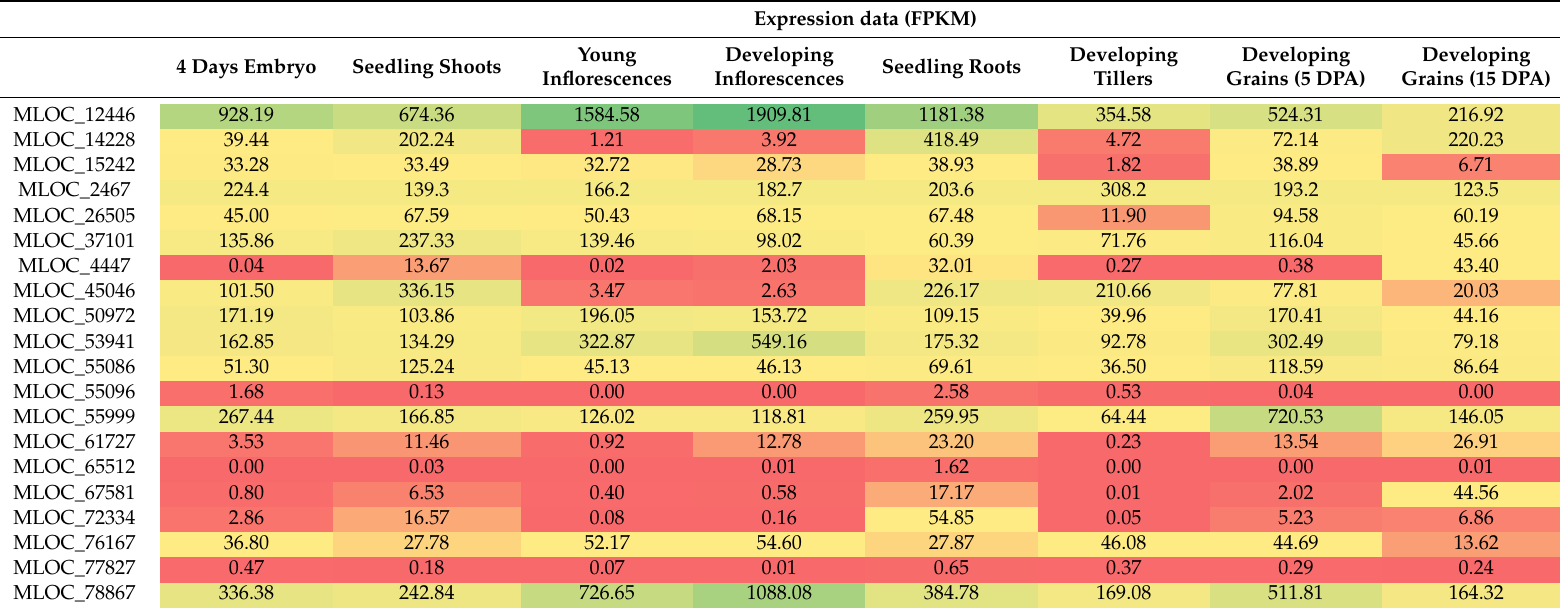
Table 2. The expression analysis of barley’s HSP70 genes obtained at https: // ics.hutton.ac.uk / morexGenes in di ff erent development stages and tissues: Embryogenesis, seedling shoots and roots, inflorescences (young and development), development tillers and development grains (5 and 15 days post anthesis DPA). The data are expressed as FPKM normalized counts of three di ff erent replicates. The colors represent the expression value from lower values (0—red) from higher values